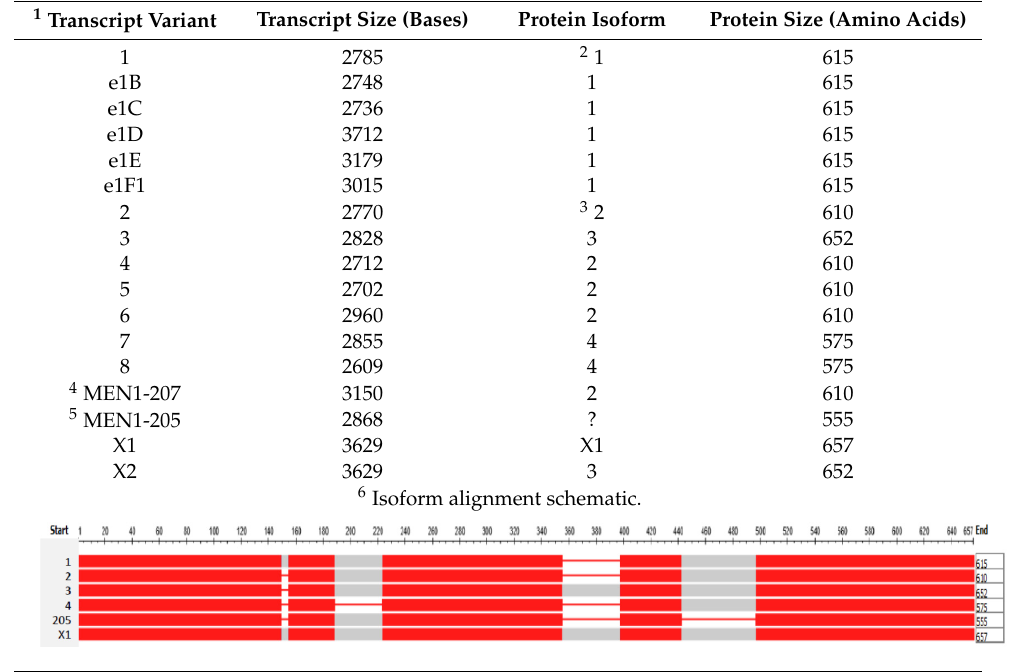
Table 2. MEN1 transcript variants and their corresponding MENIN protein isoforms. 1 Transcript